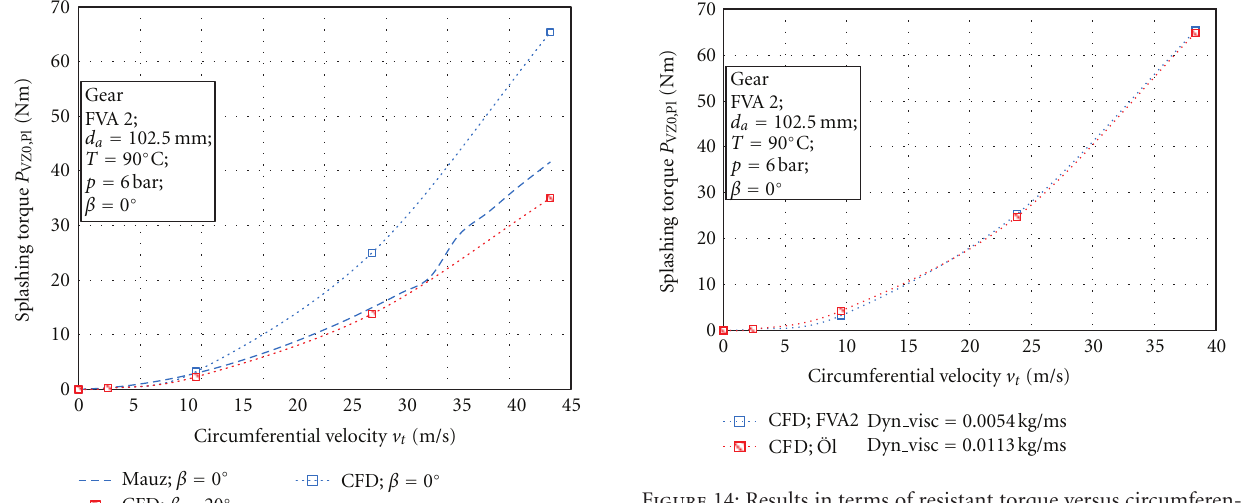
Figure 14: Results in terms of resistant torque versus circumferen- tial velocity—Influence of the lubricant viscosity.